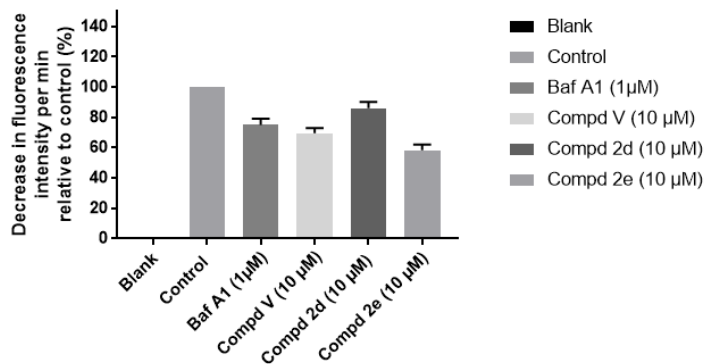
Figure 10. Effect of V-ATPase inhibitors on proton pump activity. Cells (MDA-MB-231) were subjected to acridine orange (AO) fluorescence quenching assay in the presence and absence of Baf A1 (1 µ M) and potent compounds ( V , 2d , and 2e ; 10 µ M ) . Fluorescence intensity at an excitation of 495 nm and an emission of 540 nm was quantified. Decrease in fluorescence intensity per min was calculated as percentage relative to control (mean ± SD; n =